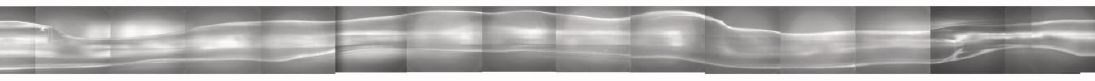
Figure 5. PIV field ‐ of ‐ view image without seeds.